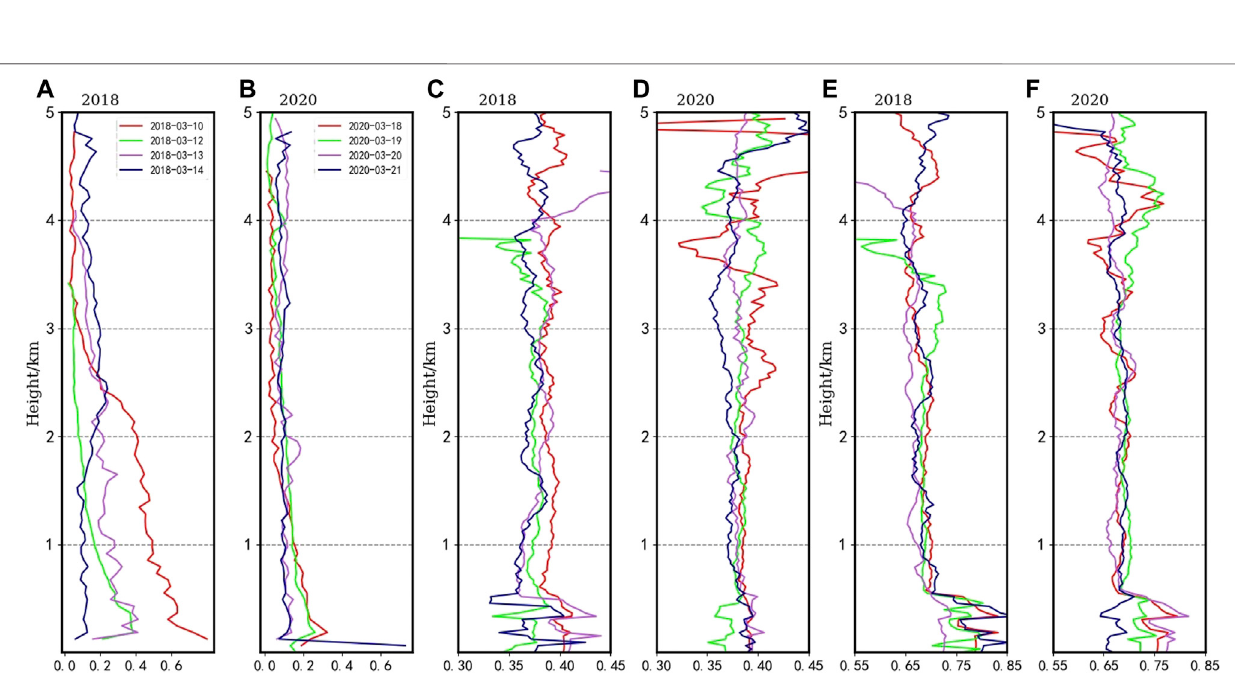
Frontiers in Environmental Science |